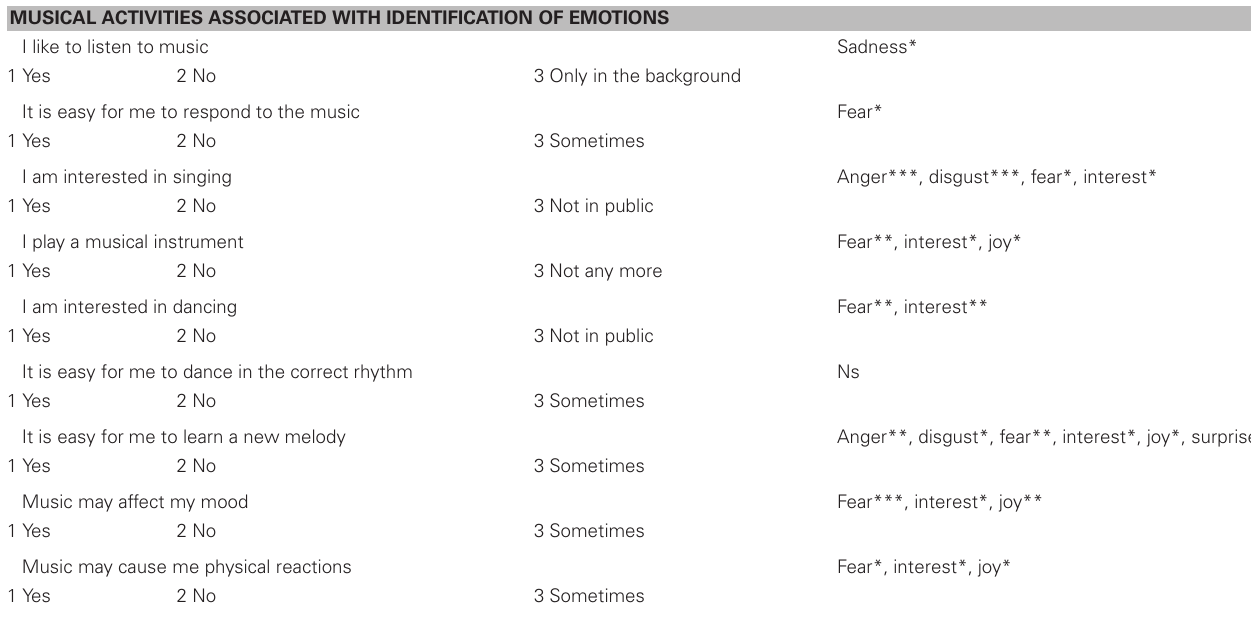
Table 4 | Emotions significantly associated with musical